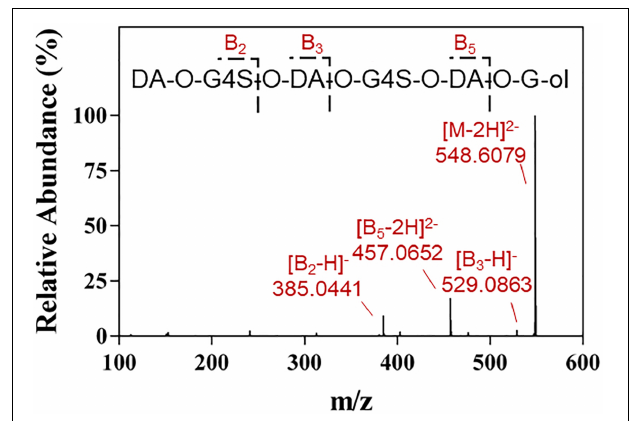
FIGURE 6 | LC-HRMS/MS analysis of the hexasaccharide component (DA-G4S) 2 (DA-G) 1 in the final product.